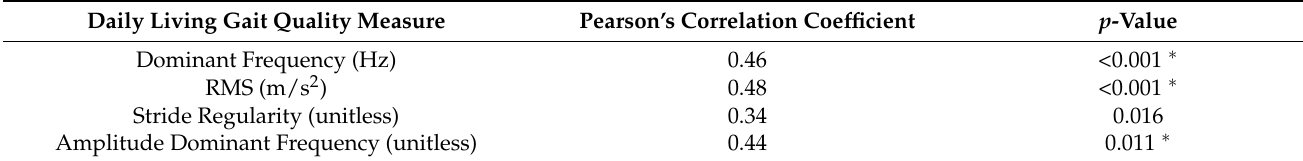
Table 9. Correlations between the gold standard and the DCNN model in the PD